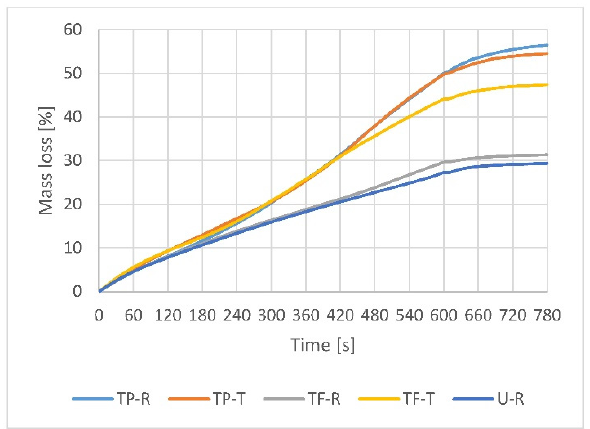
Figure 3. Average percentage mass loss of individual specimens over